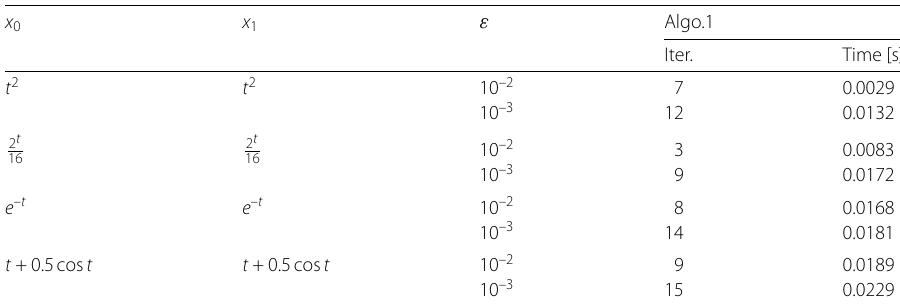
Table 4 Experiment with α n = 1